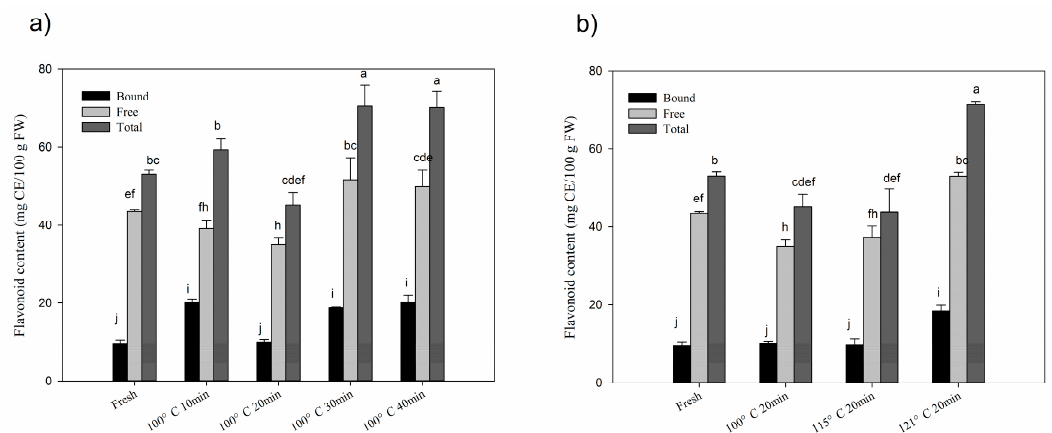
Figure 2. ( a ) Changes of flavonoid contents with time-kinetics manner at 100 ◦ C; ( b ) changes in flavonoid contents with thermal gradient manner at 20 min steaming processing. Significant differences ( p < 0.05) exist amongst those bars with different letters by Tuckey analysis.